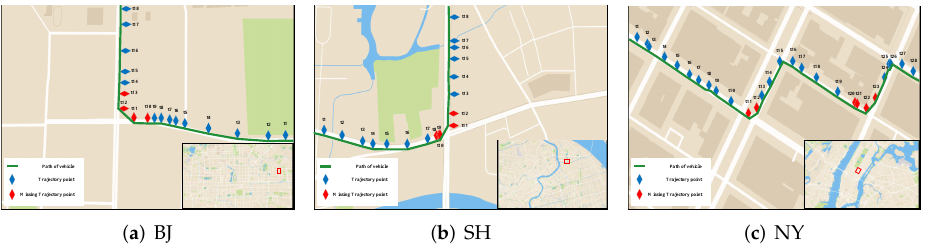
Figure 6. Sample trajectory selection of three datasets. ( a ) Taxi trajectory selection in Beijing city. ( b ) Taxi trajectory selection in Shanghai city. ( c ) Taxi trajectory selection in New York